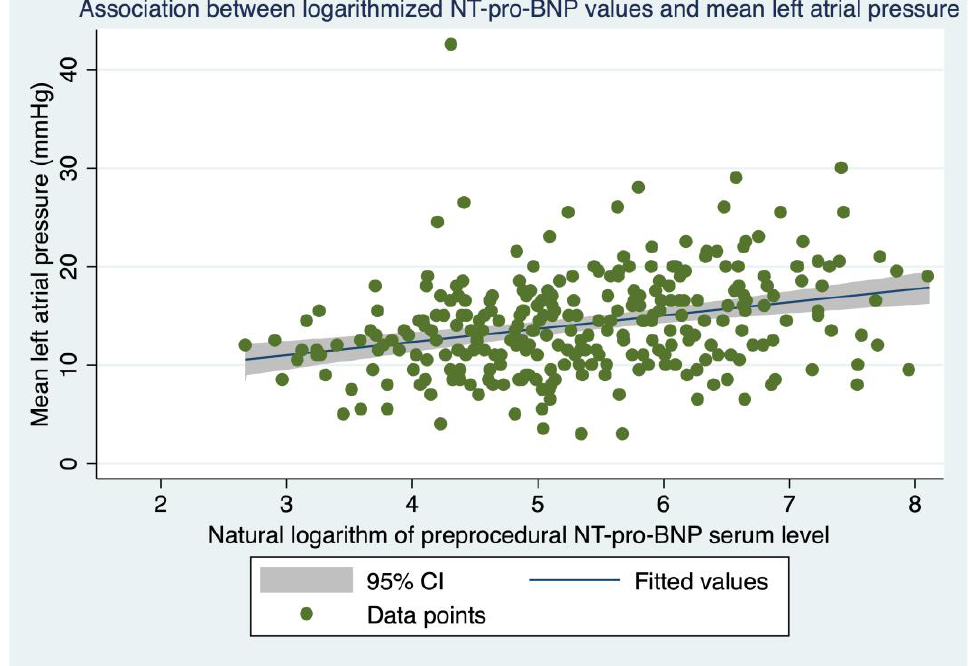
Figure 3. Association between logarithmized NT-pro-BNP values and mean left atrial pressure. Association between pre-procedural log NT-pro-BNP values and mean LAP measured during the index PVI. Blue line = regression line, gray zone = 95% confidence interval, green dots = individual data points.